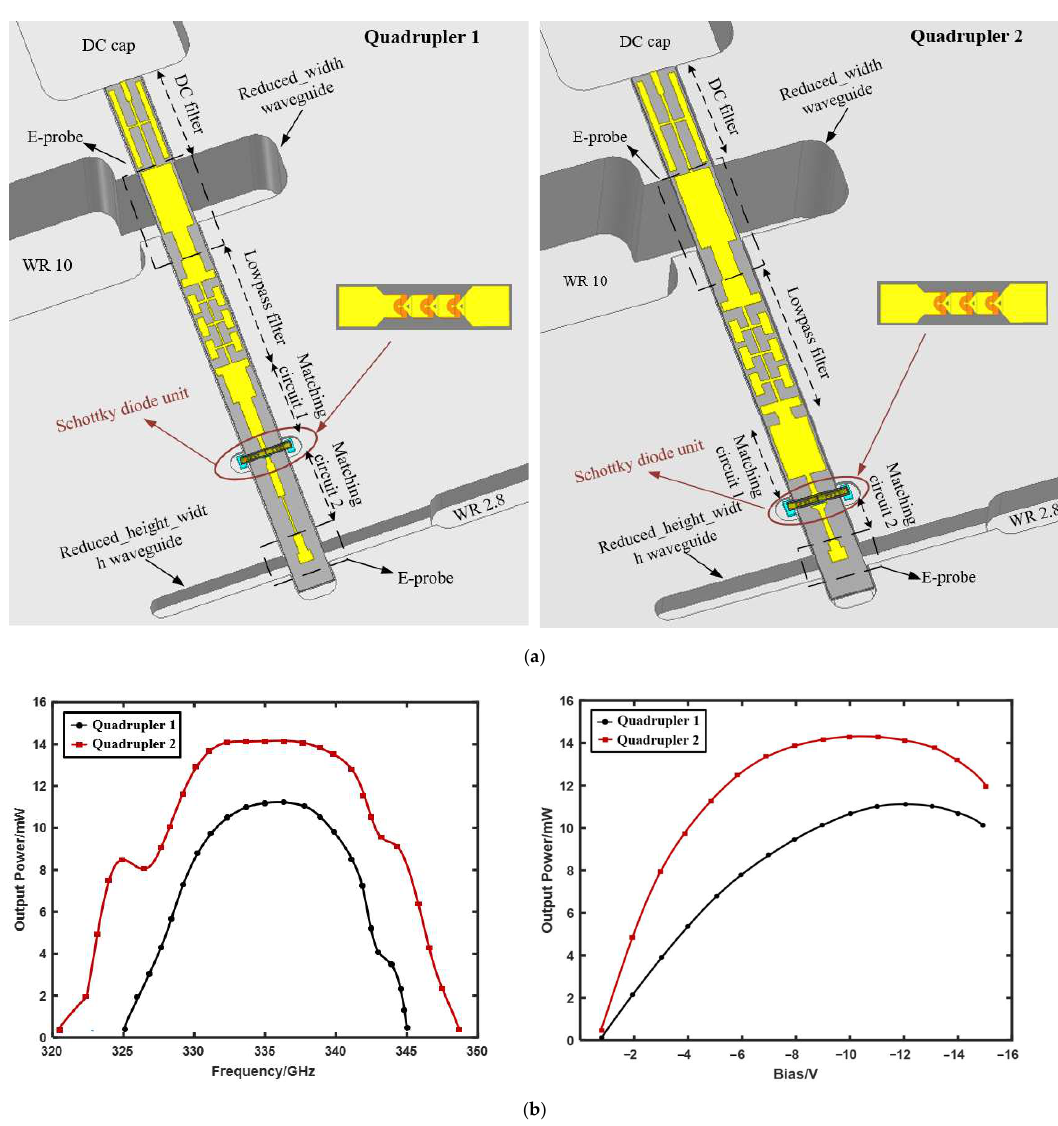
Figure 5. ( a ) Overall simulation model comparison of Quadrupler 1 and Quadrupler 2; ( b ) compar- ison of the simulation results of Quadrupler 1 and Quadrupler 2.